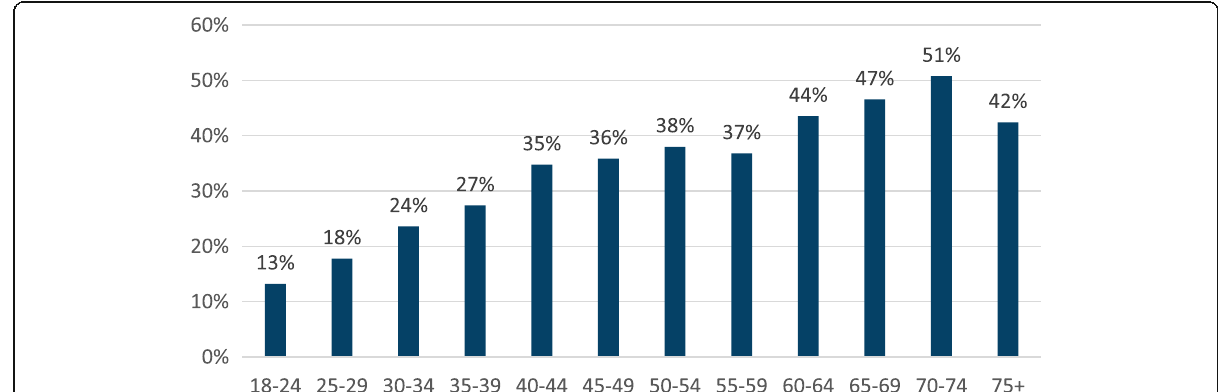
Fig. 1 Financial literacy across age in the USA. This figure shows the percentage of respondents who answered correctly all Big Three questions by age group (year 2015). Source: 2015 US National Financial Capability